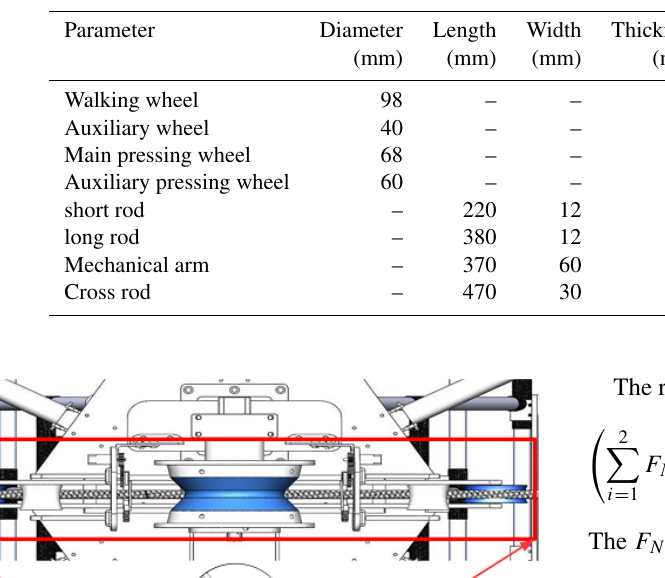
Table 1. Design parameters of the walking mechanism.